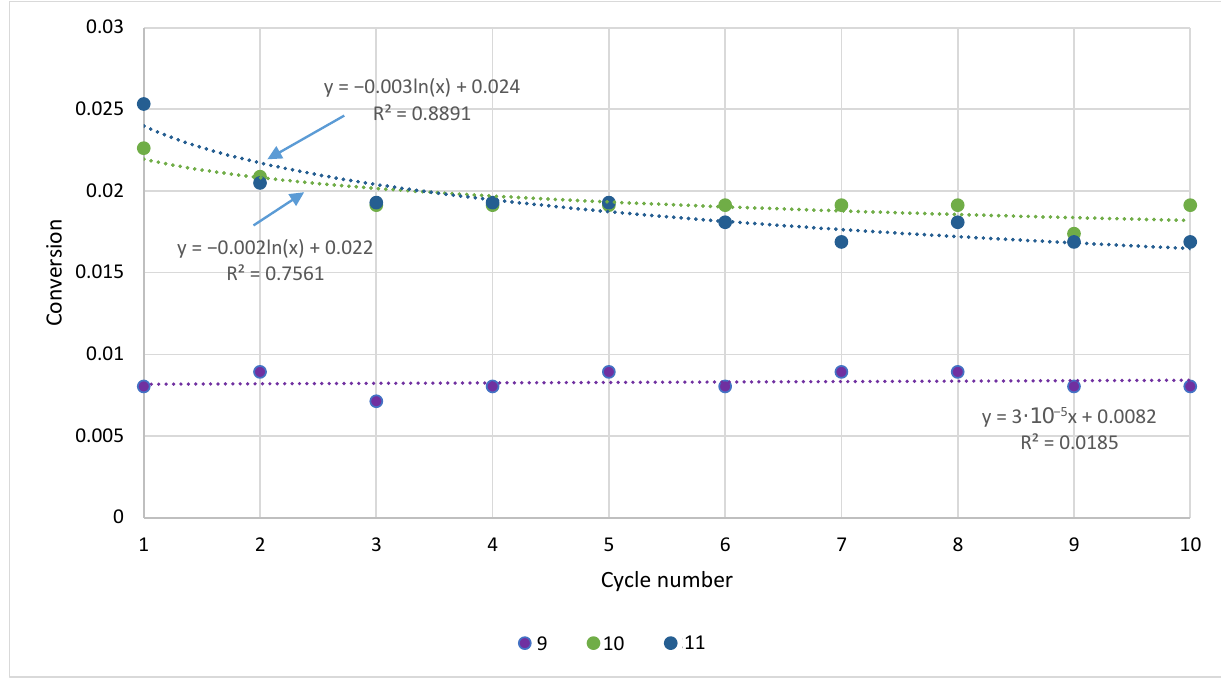
Figure 17. The conversion of magnesite and non-carbonate rocks in the CaL process.